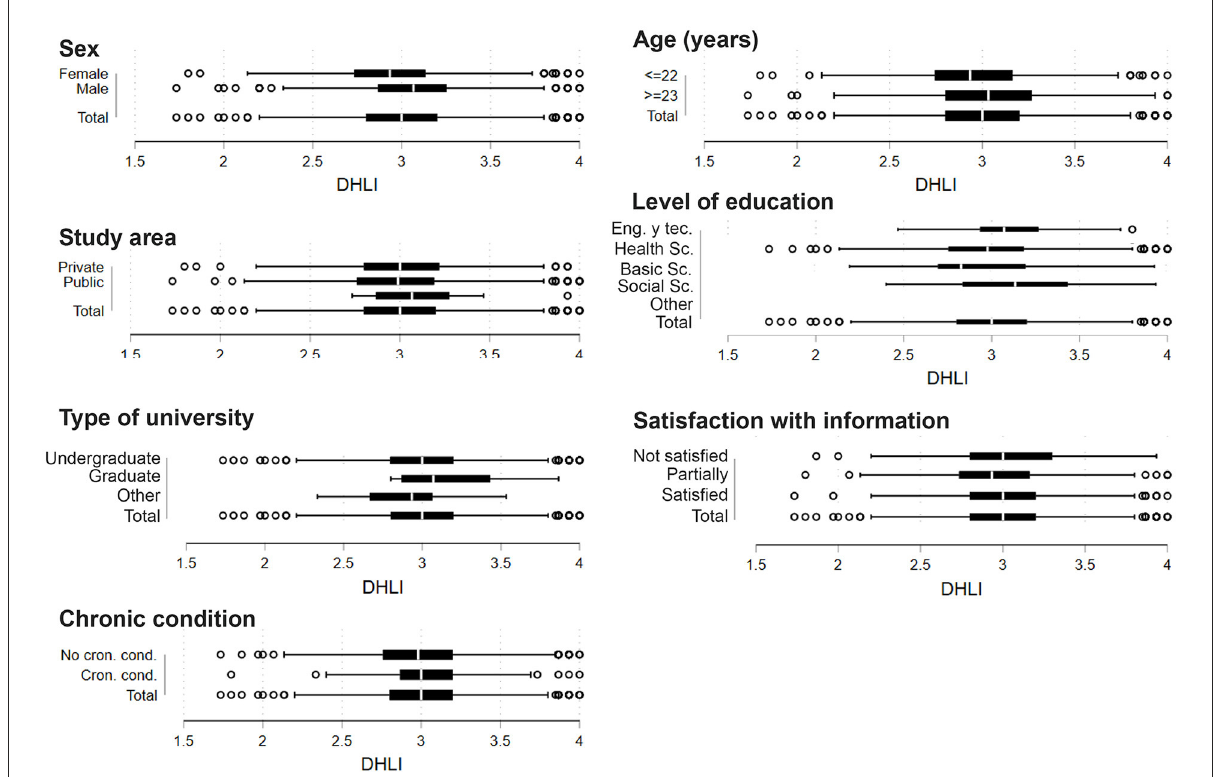
FIGURE1 Box plot between DHLI scale and characteristics of university students. Ecuador, 2020 ( n =